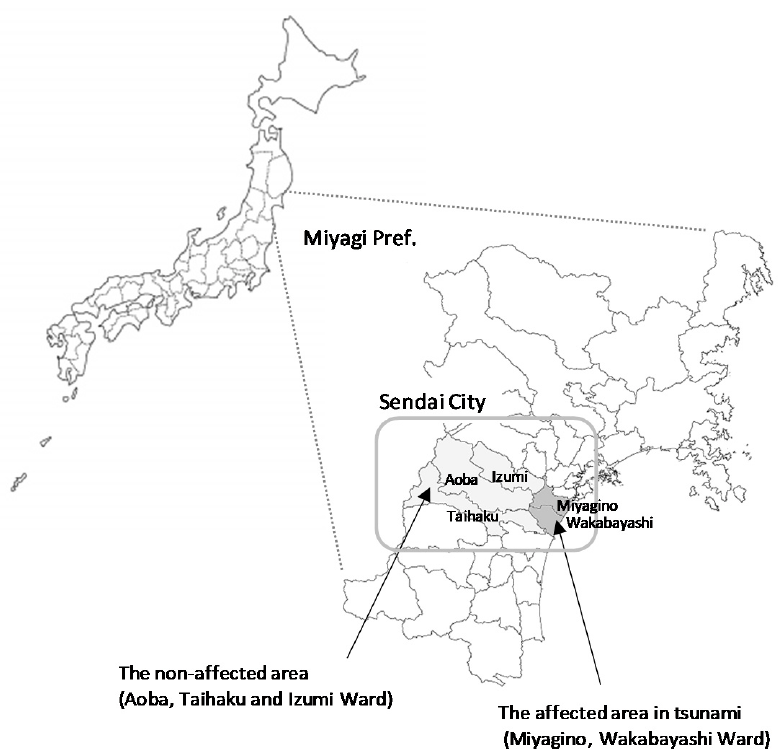
Figure 2. The GEJE and tsunami disaster-stricken areas in Sendai City. In this study, the tsunami disaster-affected area is defined as comprising Miyagino Ward and Wakabayashi Ward, both of which are proximal to the Pacific Ocean in Miyagi prefecture, and appear in dark gray. The non-affected area is defined as Aoba Ward, Taihaku Ward, and Izumi Ward, which appear in light gray.